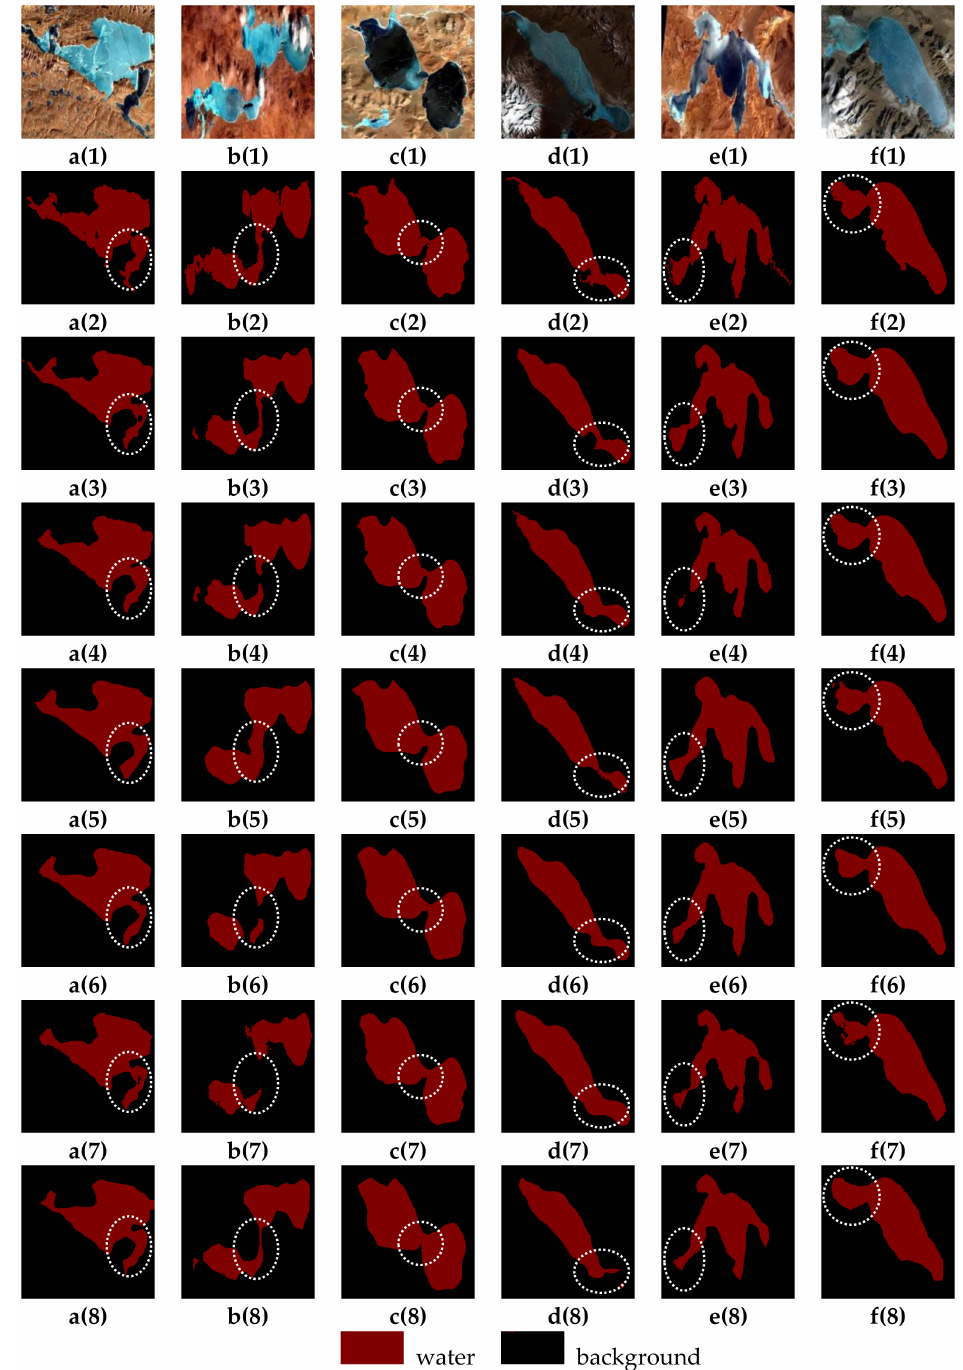
Figure 7. Visualization results for the SW dataset: a(1) – f(1) , images; a(2) – f(2) , ground truth; a(3) – f(3) , MSNANet; a(4) – f(4) , Attention U-Net; a(5) – f(5) , DeeplabV3+; a(6) – f(6) , PSPNet; a(7) – f(7) , SegNet; a(8) – f(8) , LANet. The white circles indicate obvious